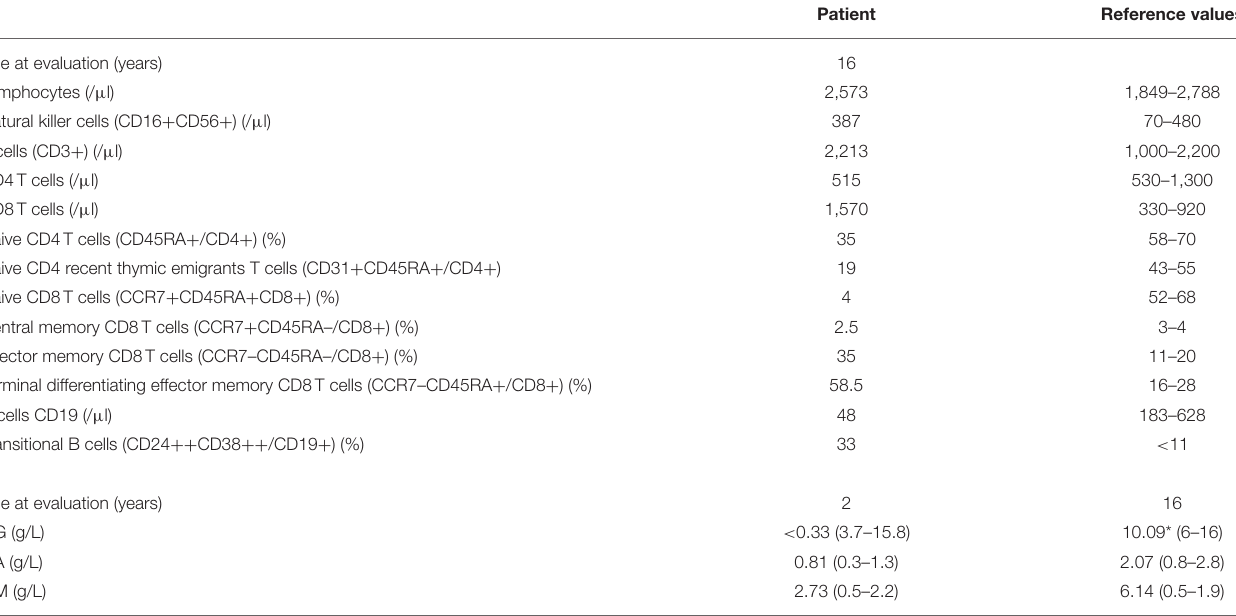
TABLE 1 | Immunological characteristics of the